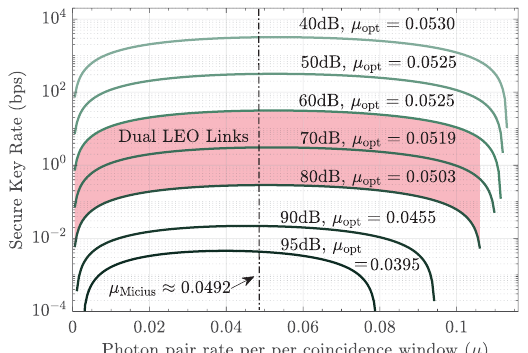
Fig. 6 Achievable secure key rates in a symmetric dual downlink scenario. The model parameters are taken from the Micius dual downlink experiment 26 . Each channel attenuation has a speci fi c optimal pair rate μ opt which yields the maximal achievable secure key rate. Additionally, the photon pair rate μ Micius emitted by Micius ’ entangled source is marked. The colored region corresponds to the link attenuation range of the Micius dual